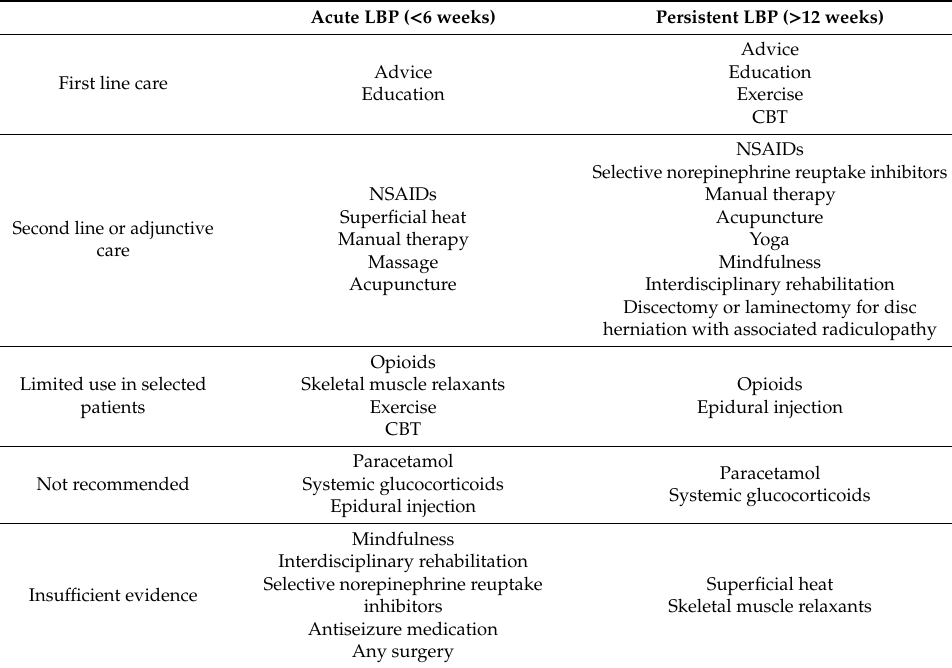
Table 1. Overview of interventions endorsed for non-specific low-back pain in evidence-based clinical practice guidelines (adapted from Foster et al. 2018)